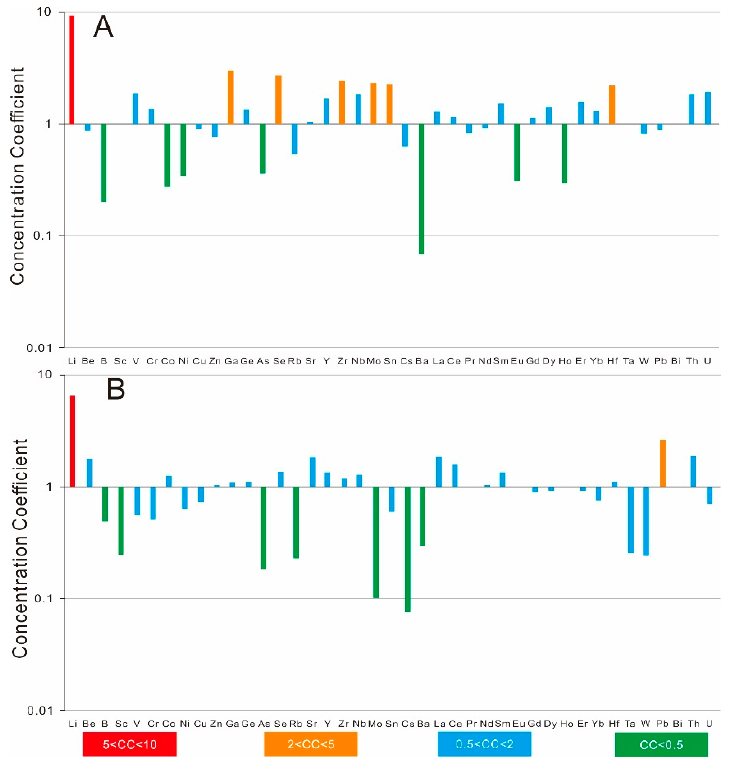
ffi cients (CC) of the trace elements in the No. 11 ( A ) and No. 3 ( B ) Figure 3. Concentration coefficients (CC) of the trace elements in the No. 11( A ) and No. 3 ( B ) coals. Figure 3. Concentration coe